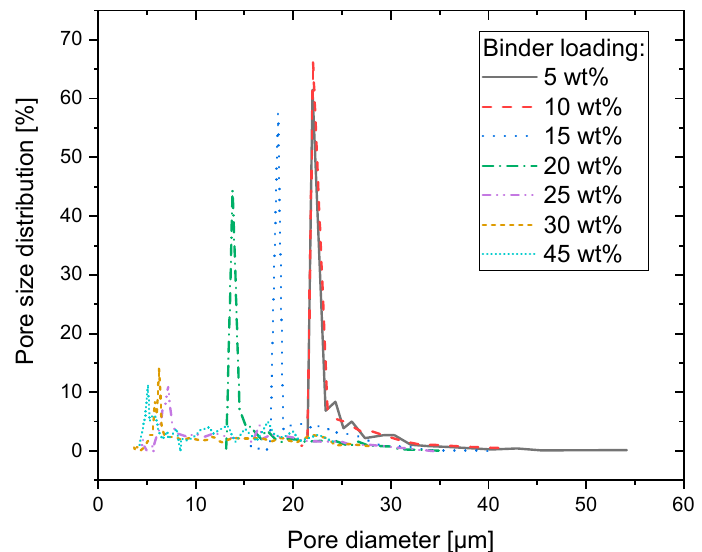
Figure 8. Pore size distribution obtained by capillary flow porometry. Pore sizes decrease with increasing BL from 23 µm to 6 µm.